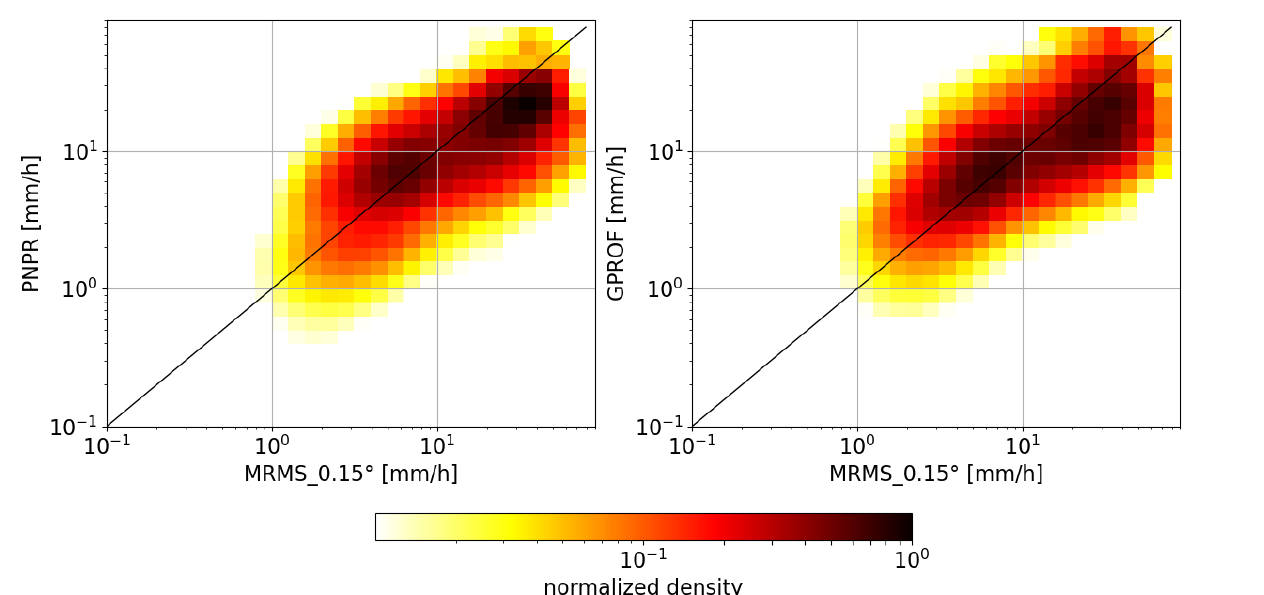
Figure 6. Joint normalized densities (see text for details) of PNPR-CLIM and MRMS ( left panel ) and GPROF and MRMS ( right panel ). The black line denotes the